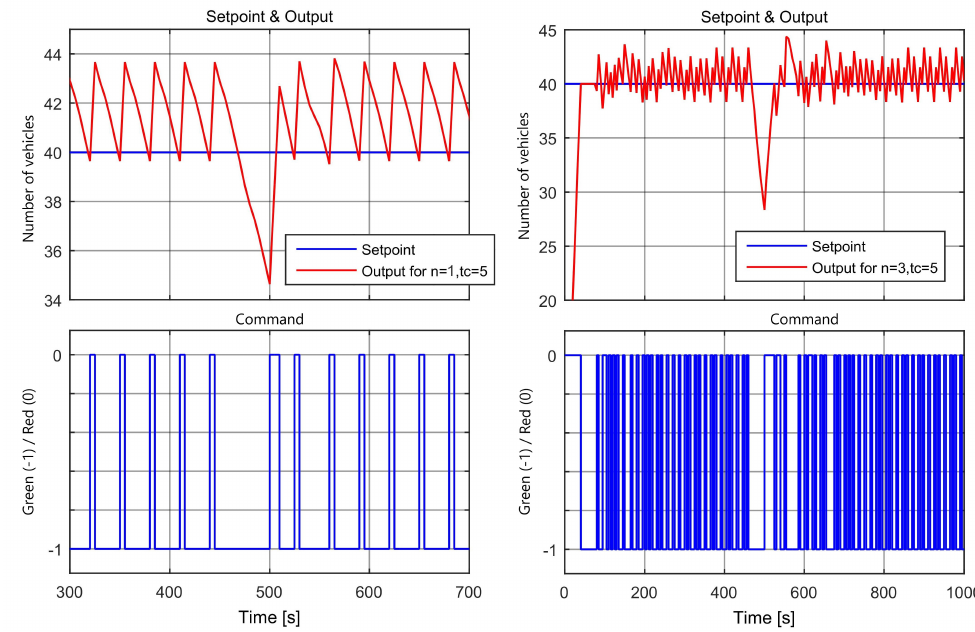
Figure 8. Behavior for setpoint 40 vehicles, where n = 1, n = 3, and τ c = 5 s.